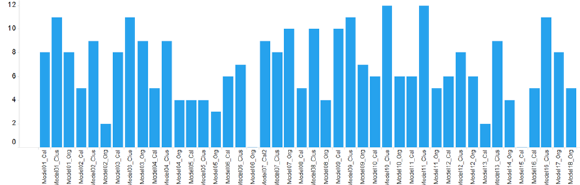
Figure 5. Benchmarking results of chlorophyll a